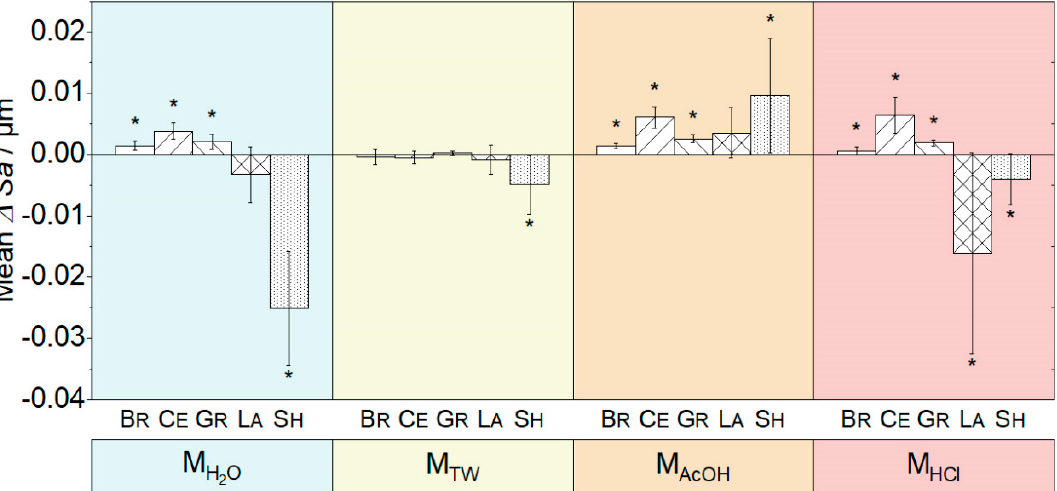
Figure 1. Changes in the mean and standard deviation of the surface roughness (Sa) (t 1 − t 0 ) due to immersion in the different media M H2O (demineralized water), M TW (tonic water), M AcOH (acetic acid) and M HCl (hydrochloric acid) (* indicates p < 0.05).